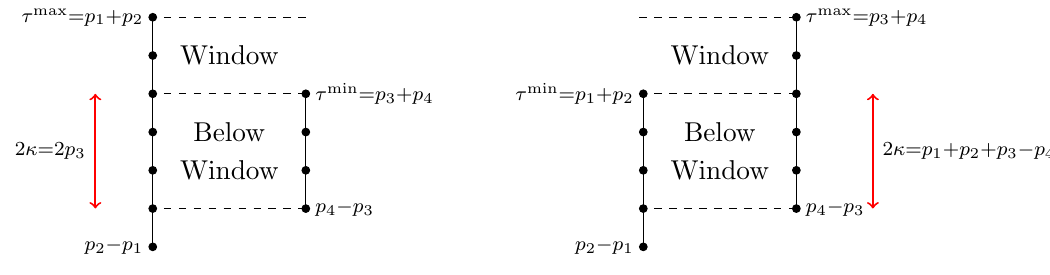
Figure 2 . Illustration of the possible su (4) representations exchanged in the overlap of the ( O p (cid:2) O p ) and ( O p (cid:2) O p ) OPEs. The vertical axis represents the possible values of b + 2 a 1 2 3 4